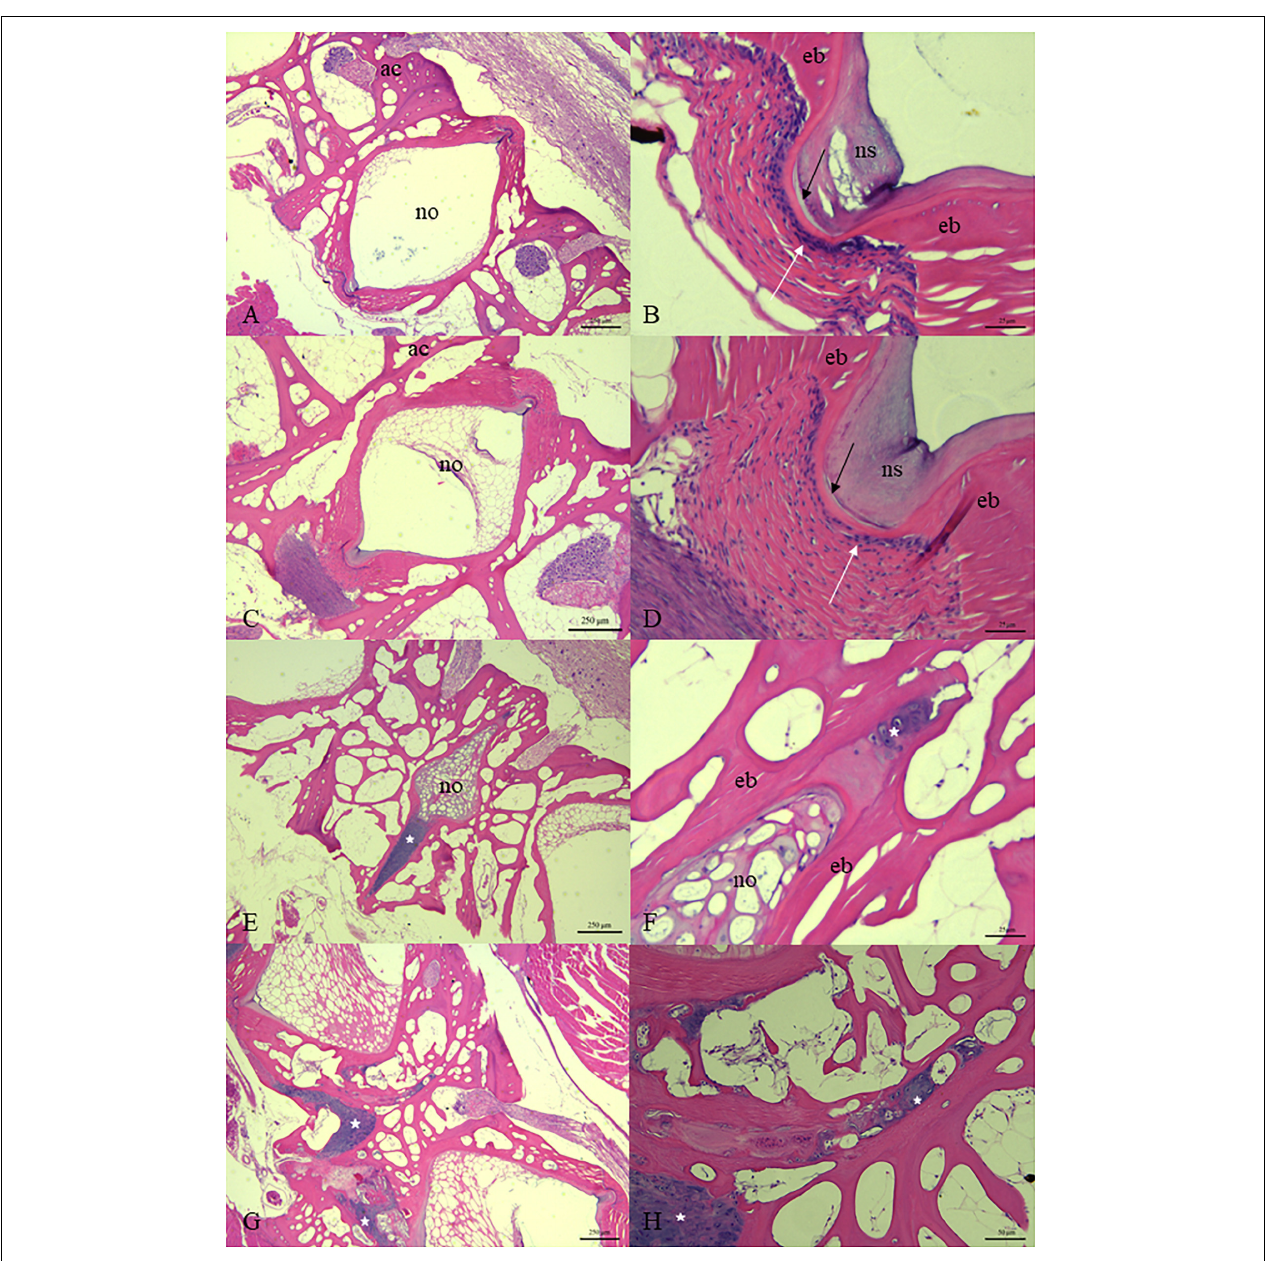
FIGURE 4 | Histology of vertebral column of juvenile T. ovatus from LT group (A,B) , HT group [ (C–H) while (E–H) were samples of vertebrae with fusion]. The white arrow points to the osteogenic layer in the growth area of the vertebral endplate. The black arrow points to the elastic externa. White asterisk is located in the growth area of the vertebral endplate. ac, arch centra; no, notochord; ns, notochord sheath, ed, endbone. [ (A,C,E , G) 50 × magnification; (H) 200 × magnification; (B,D , F) 400 ×